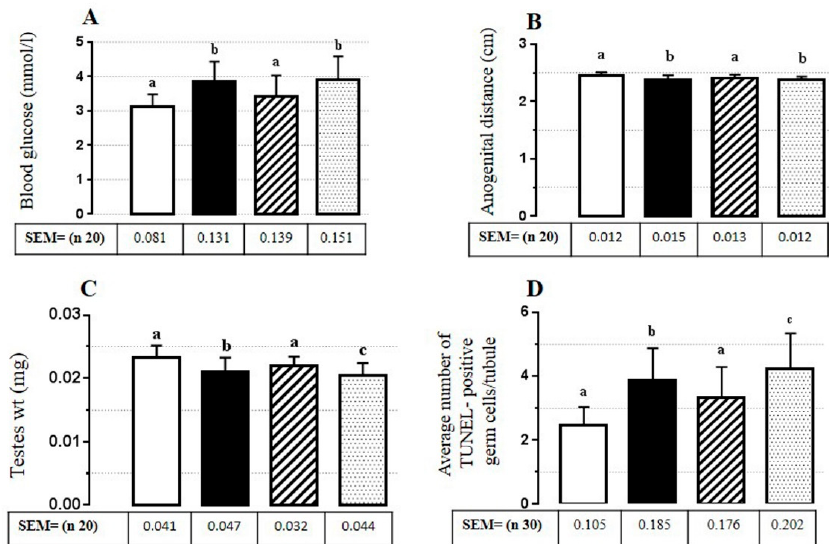
Figure 2. Blood glucose level, anogenital distance, testis weight, and terminal deoxynucleotidyl transferase dUTP nick end labeling (TUNEL)-positive germ cells in experimental mice. ( A ) The dose of 2 mg / kg resveratrol (RES) in maternal restraint stress decreased blood glucose level in pups 7 days of age. Glucose was mainly increased by maternal restraint stress and 20 mg / kg. ( B ) Resveratrol 2 mg also a ff ected anogenital distance, which was mainly decreased in the groups of maternal restraint stress and 20 mg / kg dose. ( C ) The average number of TUNEL-positive cells significantly decreased in the group of 2 mg / kg and was significantly higher in the maternal restraint stress and the 20 mg / kg groups. ( D ) Testes weight decreased in maternal restraint stress and 20 mg / kg groups, while it increased in